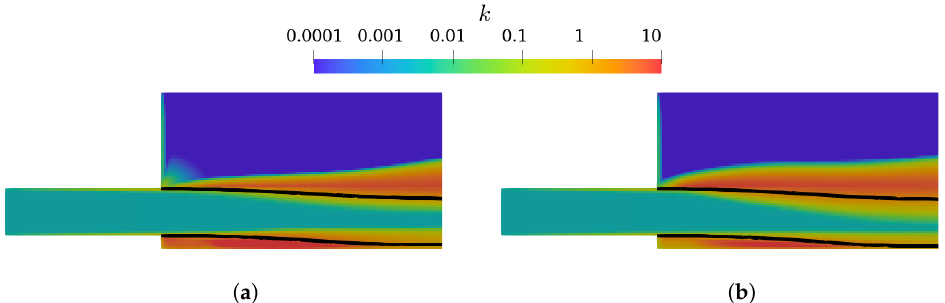
Figure 11. k at vertical central plane of the TPVoF model with R m = 20; interface ( α = 0.5, black line). ( a ) k – (cid:101) . ( b ) k – ω SST